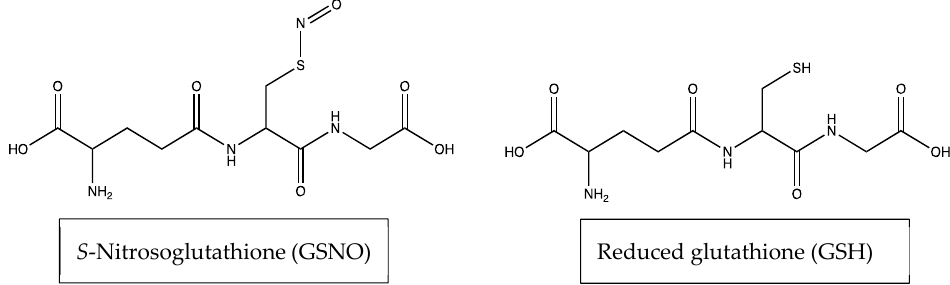
Figure 1. Structures of S -Nitrosoglutathione (GSNO) and reduced glutathione (GSH).